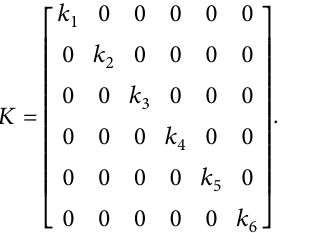
, (b) F , (c) F , (d) F , (e) F , and (f) F 1 x 1 z 2 x 2 z 3 x